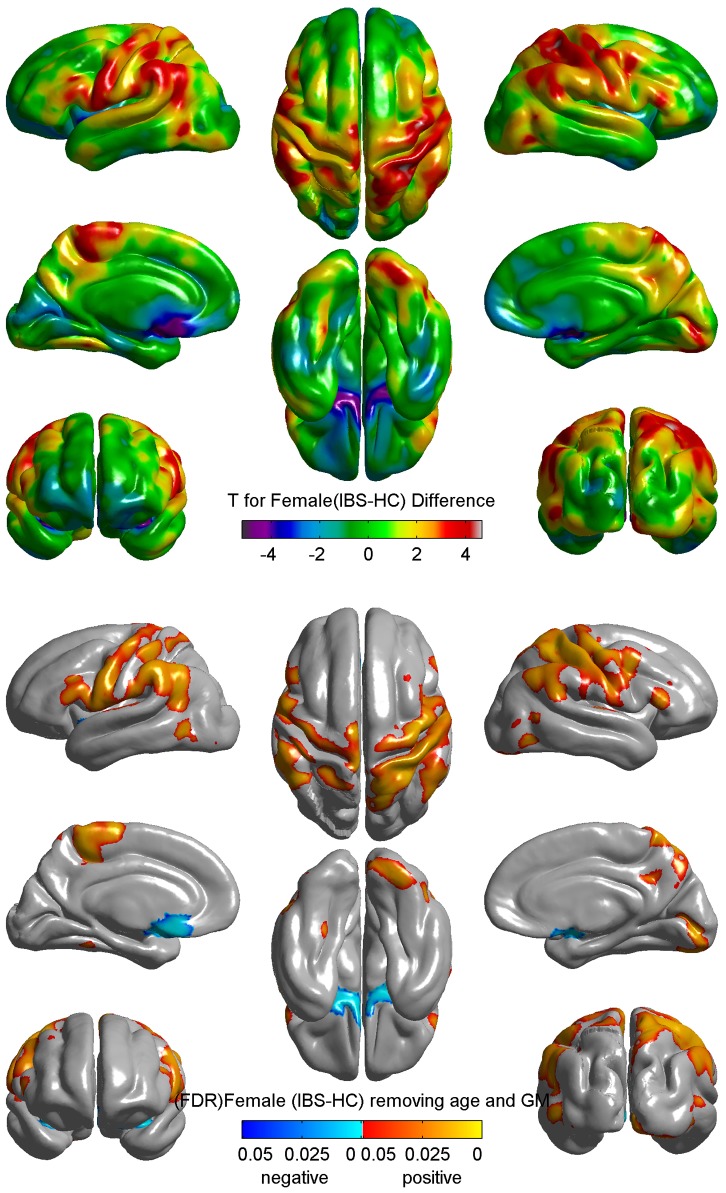
Differences in Cortical Thickness between Female IBS and Female HC.Upper: difference between female IBS and female controls from whole brain grey matter thickness analysis projected on average surfaces. T maps (uncorrected) were color coded: orange/red = thickening; blue/purple = thinning. Green = no change. Lower: FDR corrected p map from whole brain grey matter thickness analysis. Orange/red = female>male; blue/cyan = female<male. Cortical GM thickness was reduced in bilateral subgenual ACC and increased in bilateral motor and somatosensory cortex after controlling age and total grey matter volume. Groups: Healthy Control (HC); Irritable bowel syndrome (IBS).